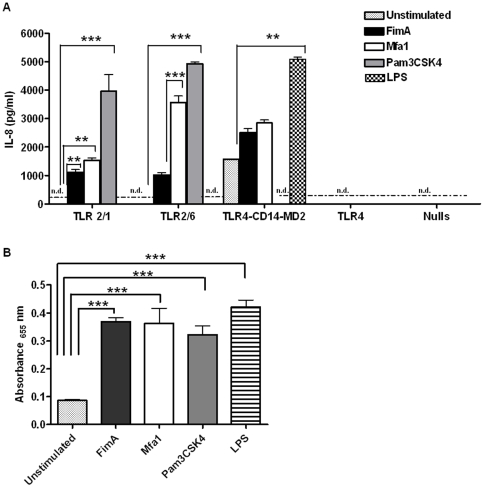
rFimA and rMfa1 signal preferentially through TLR2/6.(A) HEK 293 cells stably expressing TLR2, 4, 2/1, 2/6 or TLR4-CD14-MD2 were stimulated with 1 µg/ml of rFimA, rMfa1, the classic TLR2-specific agonist, Pam3CSK4 or the classic TLR4-specific agonist E. coli LPS. IL-8 release was quantified in 20 hr cell-free supernatants by ELISA. n.d.  =  not detected (below assay threshold); *p<0.05; **p<0.01; ***p<0.001. (B) THP-1 Blue cells are stably transfected with a reporter plasmid expressing secreted embryonic alkaline phosphatase (SEAP) gene under the control of a NF-κB-inducible promoter. THP-1 Blue cells were stimulated with 1 µg/ml of rFimA, rMfa1, Pam3CSK4 or E. coli LPS. Relative expression levels of SEAP (reflecting NF-κB) in cell-free supernatants were determined by spectrophotometric analysis of SEAP activity at 655 nm. Unstimulated cells represent the 100% control. Here we show that all TLR-agonists employed are equally capable of inducing NF-κB. ***p<0.001 compared to unstimulated cells.